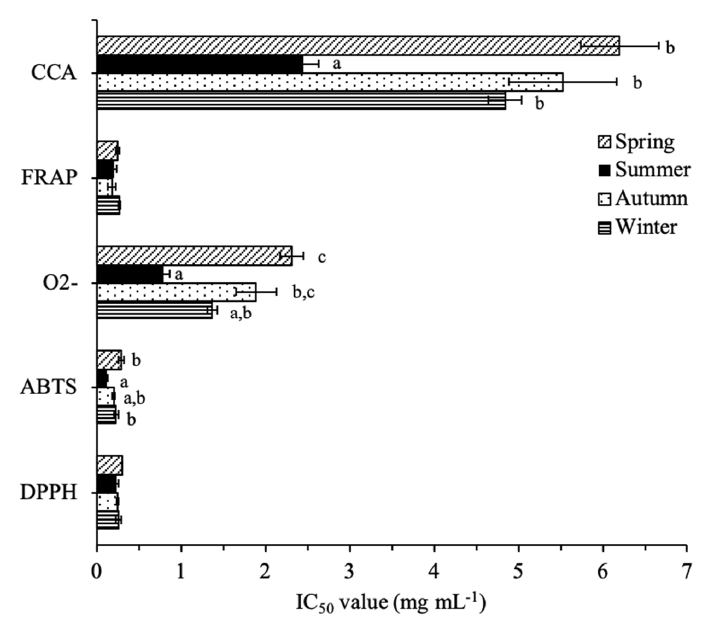
Figure 3. Seasonal variation of the antioxidant capacity of sawgrass ( C. mariscus ) extracts. Values are expressed as IC 50 with the standard deviation represented (n = 3). Different letters superscript correspond to significant differences between seasons, for each assay ( p < 0.05; Tukey HSD). CCA: Copper chelating activity; FRAP: Ferric reduction antioxidant power.